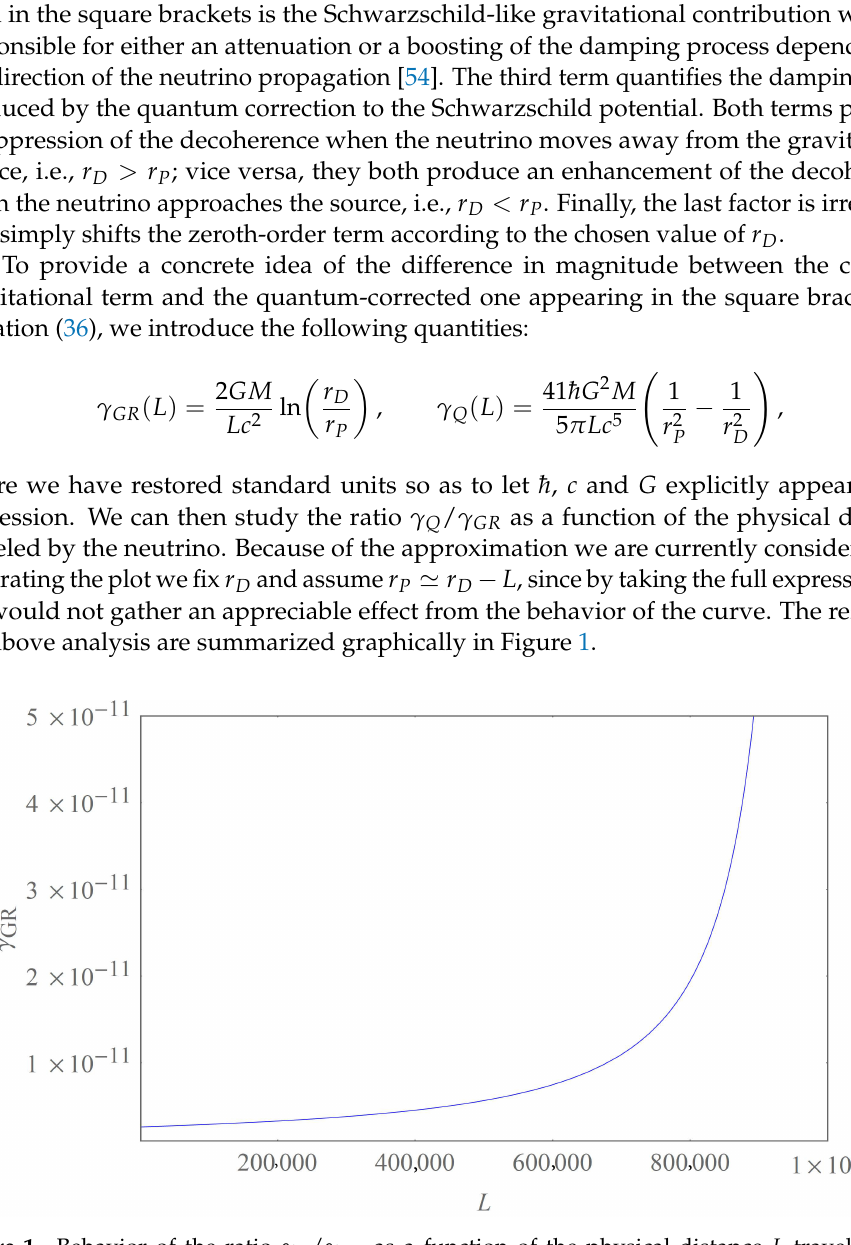
Figure 1. Behavior of the ratio γ Q / γ GR as a function of the physical distance L traveled by a propagating neutrino in the interval [ 10 3 ,10 6 ] at the sample values ¯ h = c = G = 1, r D = 10 6 and M = 1. Should we restore the standard units, the above ratio would be further reduced by a factor equal to the squared Planck length ‘ p = ¯ hG / c 3 .